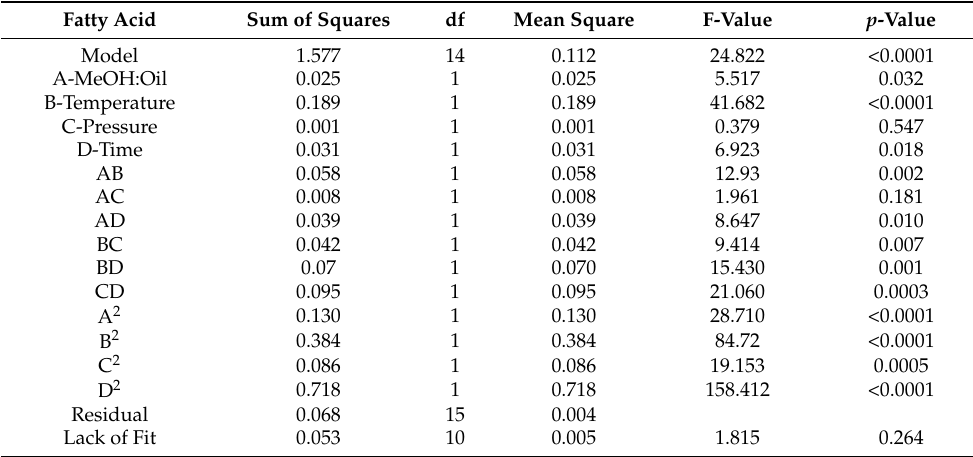
Table 5. Analysis of variance for FAME yield of methyl-oleate model. Fatty Acid Sum of